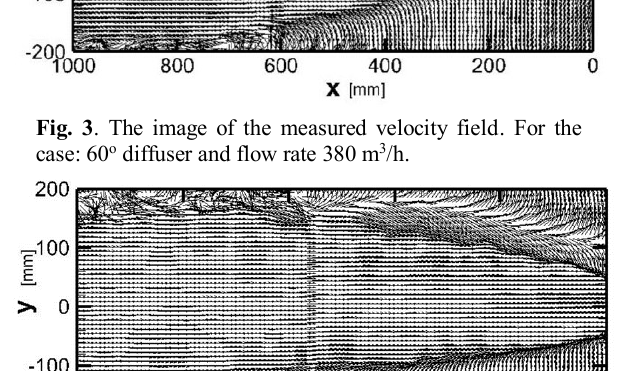
Fig. 1. Set-up of the measurement section: 1- laser Nd:YAG, 2- camera CCD, 3-swirl diffuser.